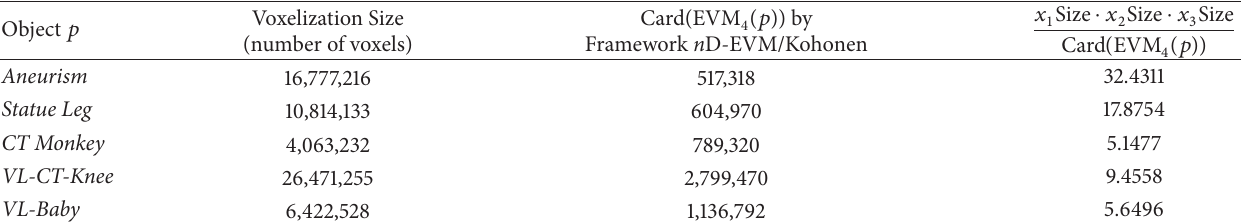
Table 15: The ratio number of voxels/number-of-extreme-vertices for datasets shown in Tables 1 and 7 after processing via Framework 𝑛 D-